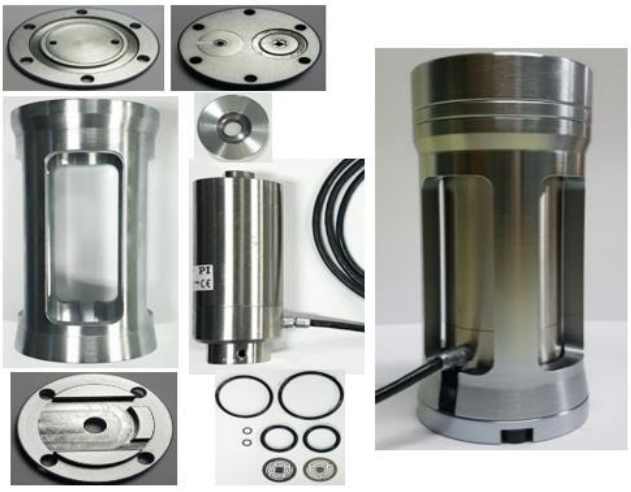
Figure 11. Components of the designed piezoelectric-hydraulic pump used in the experiment.